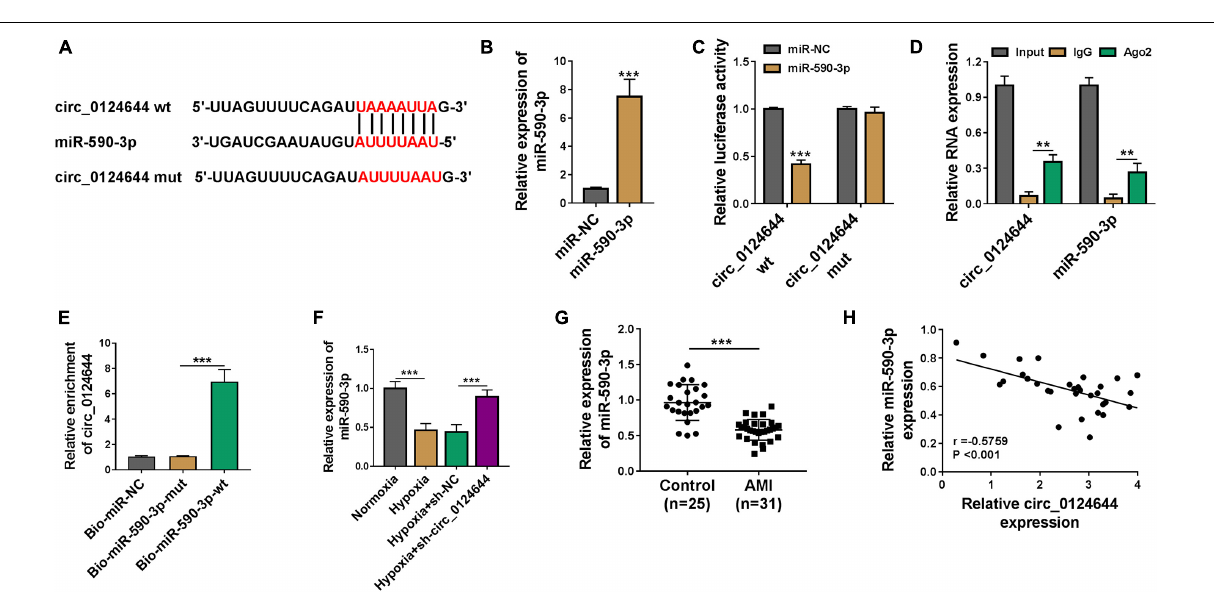
Frontiers in Genetics |